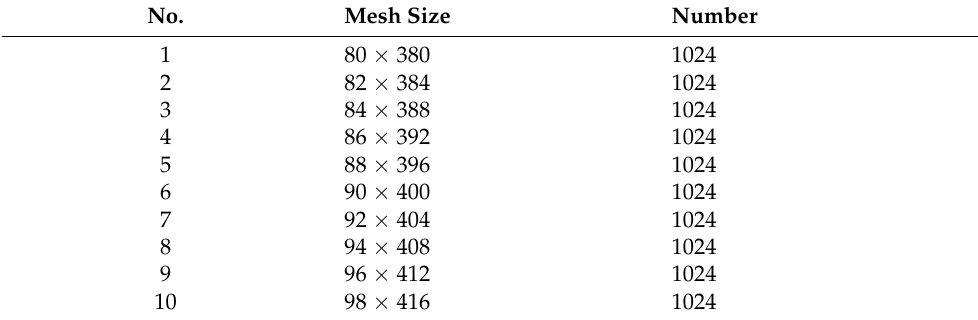
Table 1. Different size meshes.